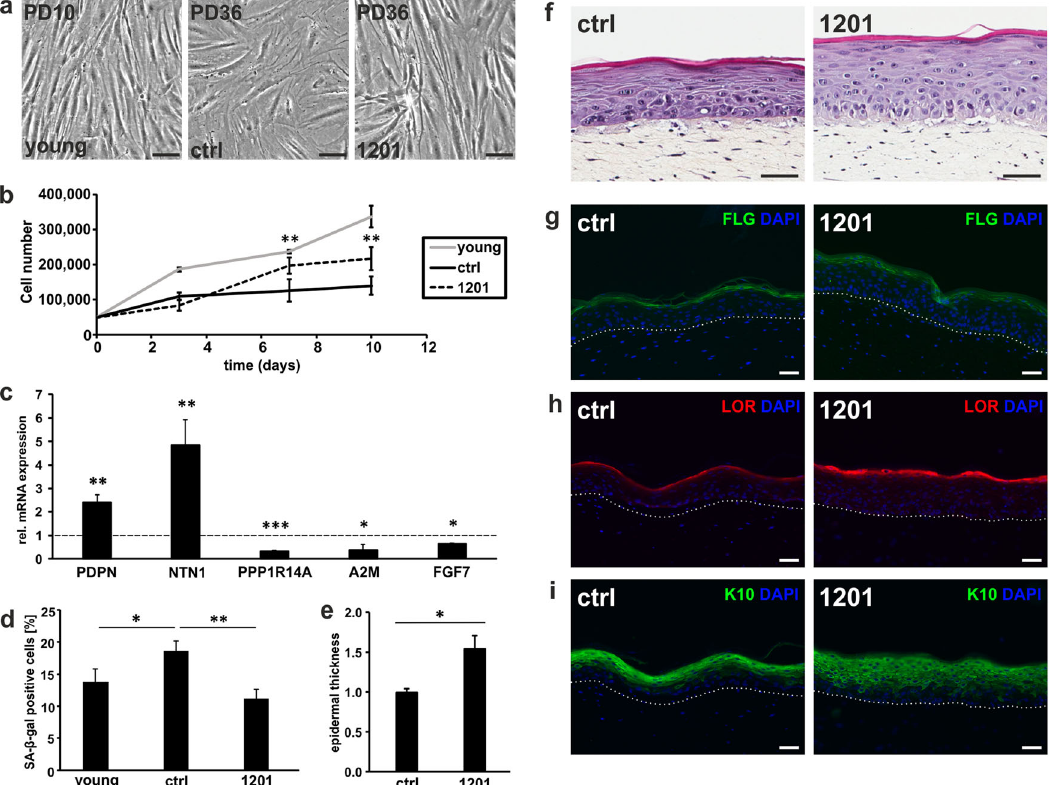
Fig. 2 1201 reverses the papillary to reticular transition. a HDFs were cultivated for fi ve PDs in growth medium supplemented with 1201. Replicatively young cells (PD 10) served as a young control. Representative pictures from one experiment at ×100 magni fi cation. Scale bar, 100 µm. Subsequent to the treatment as described in a , cells were used for b proliferation assay, c RT-qPCR of markers for the papillary/ reticular phenotype and FGF7 (expression levels of untreated control cells were set to 1) and d SA- β -gal staining. e Full-thickness human skin equivalents (HSE) were constructed as described in the Methods section. The average of the epidermal thickness was calculated from at least 50 measurements per HSE and the epidermal thickness of untreated HSEs was set to 1. f Representative pictures from one experiment as described in e . Scale bar, 50 µm. Immunohistochemistry of HSEs as described in e was performed with antibodies against g fi laggrin, h loricrin and i keratin 10. The white dotted line separates the epidermal from the dermal layer. Scale bar, 50 µm. For b – d , data represent the average of three experiments. For e , data represent the average of two experiments. Statistical signi fi cance for the treatment in b was calculated with a two-way ANOVA ( p = 0.004) followed by a Bonferroni post hoc test. Statistical signi fi cance for the treatment in d was calculated with a one- way ANOVA ( p = 0.004) followed by a Bonferroni post hoc